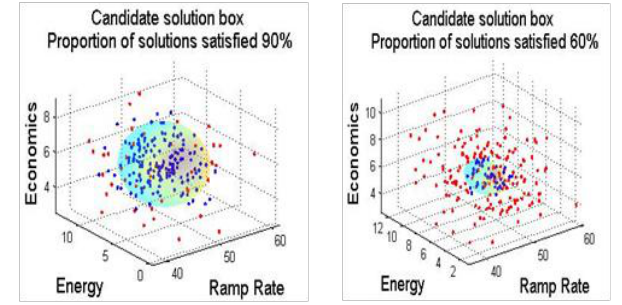
Figure 5. Comparison between high and low